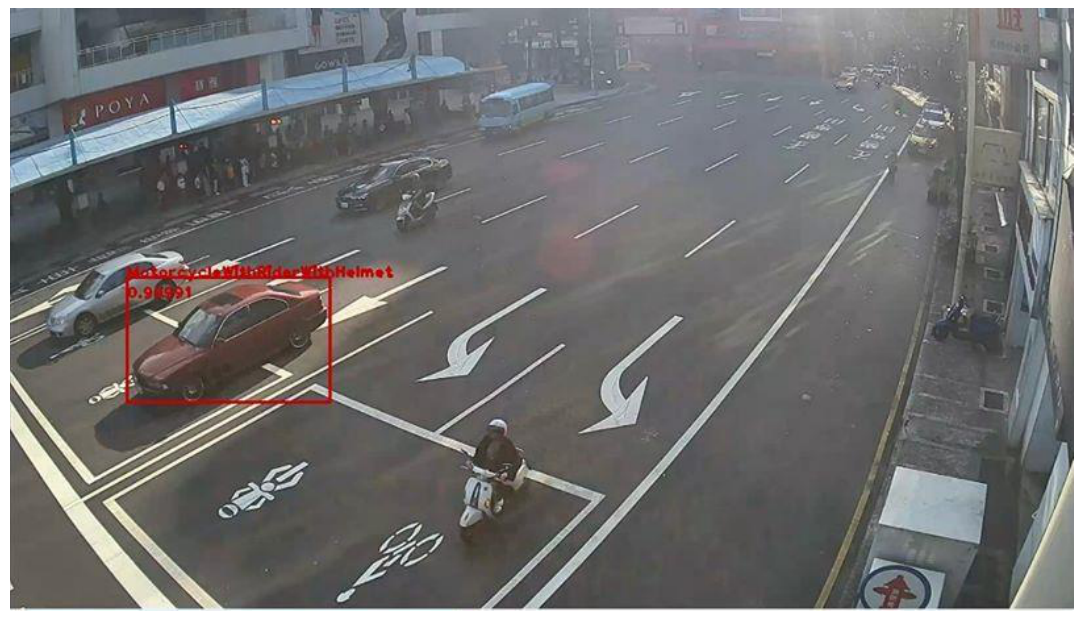
Figure 22. Low-contrast scene image frame detected by YOLOv3.